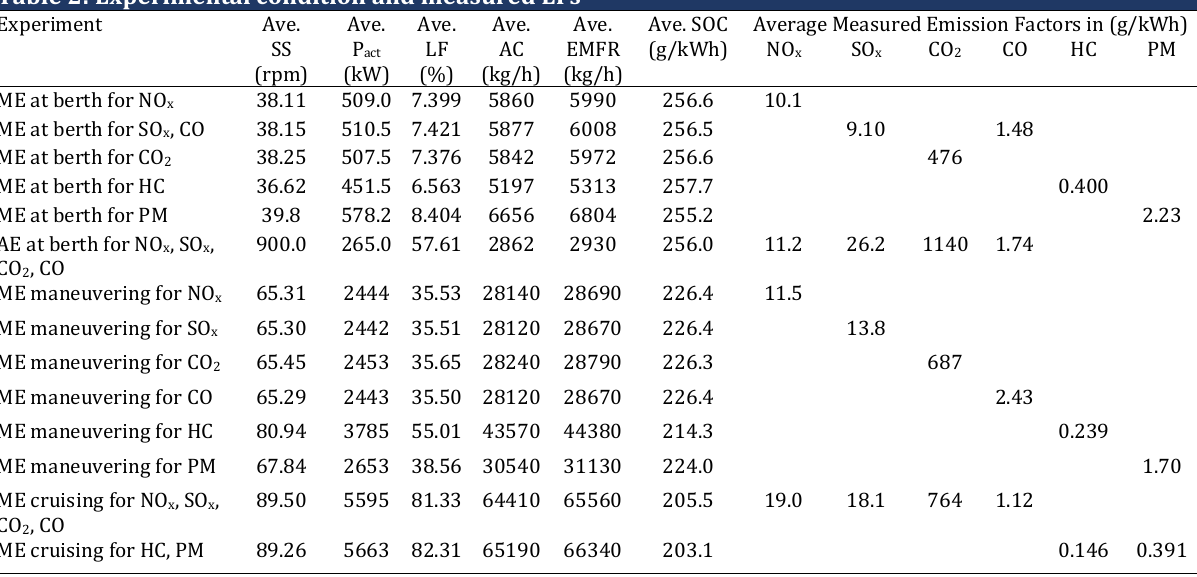
Table 2: Experimental condition and measured EFs